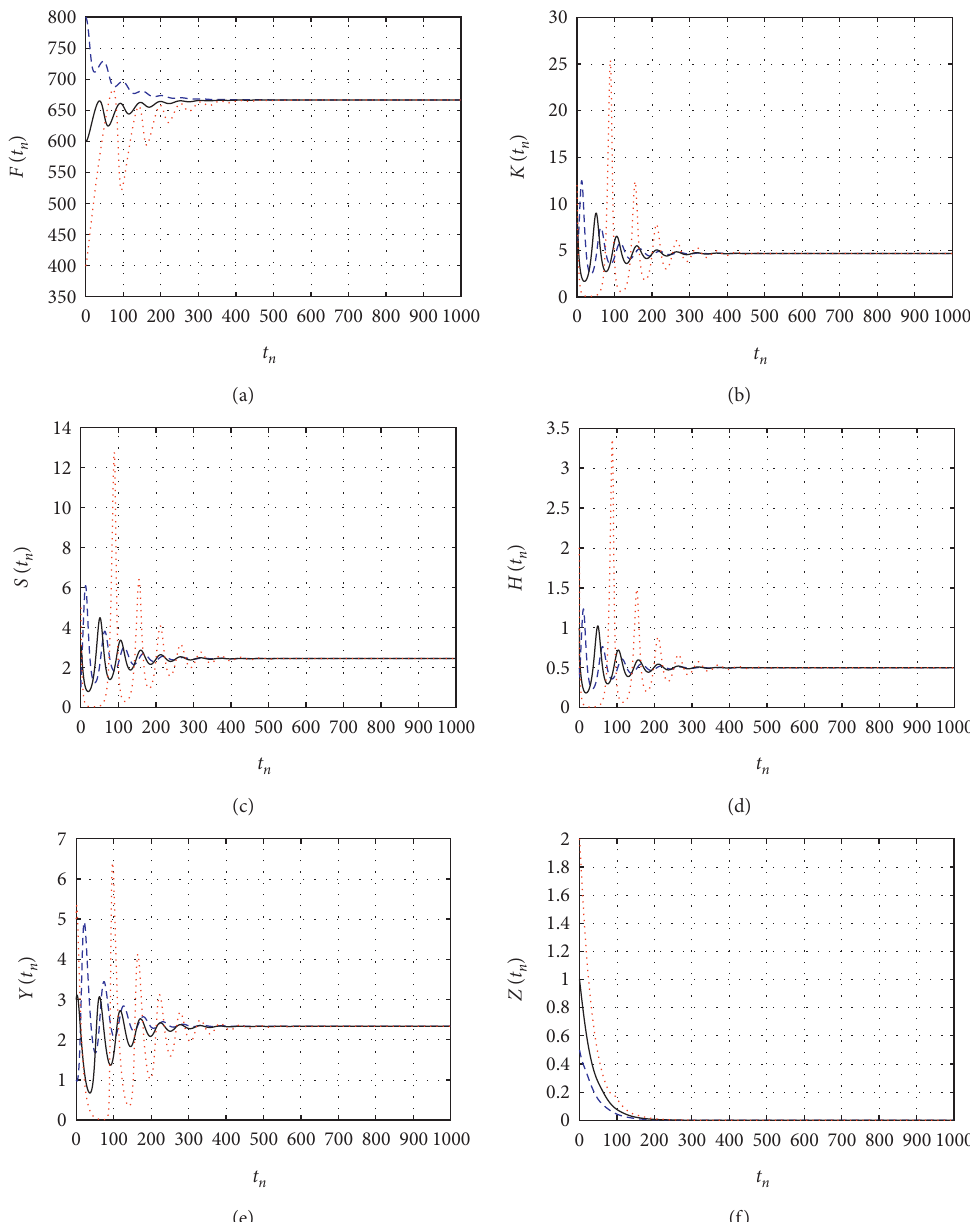
Figure 3: The solutions of systems (12)–(17) for case R Y